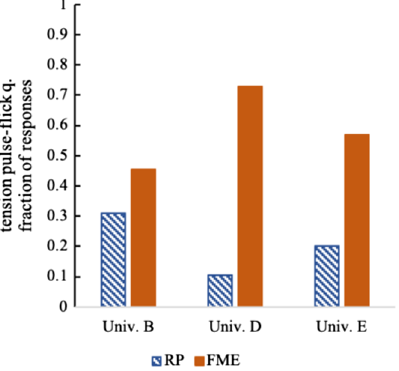
FIG. 15. Fraction of responses assigned the RP or FME codes for the explain-style question on propagation (the tension pulse- flick question).